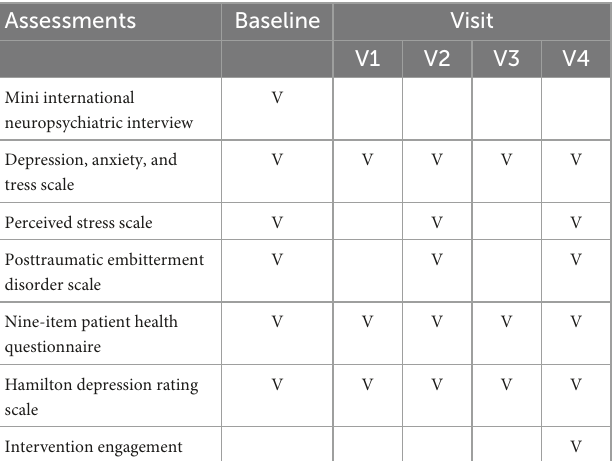
TABLE 2 Schedule for